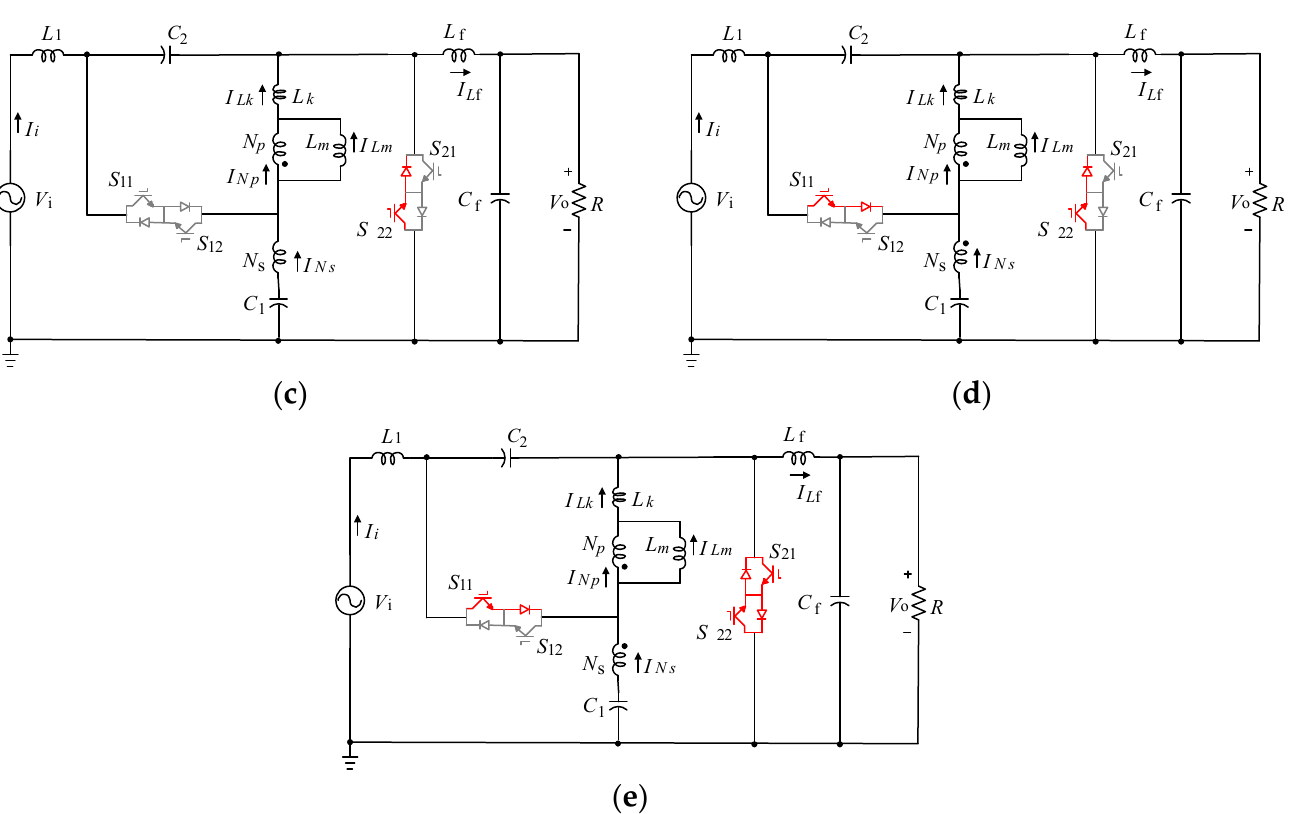
Figure 5. Operation intervals of the introduced topology for boost in-phase state when V i > 0, ( a ): non-shoot-through state, ( b ): commutation state if I i + I Lk − I lf > 0, ( c ): commutation mode when I i + I lk − I lf < 0 and I Lk = I Lm , ( d ): commutation state if I i + I lk - I lf < 0 and I Lk − I Lm < 0, ( e ): shoot-through state.